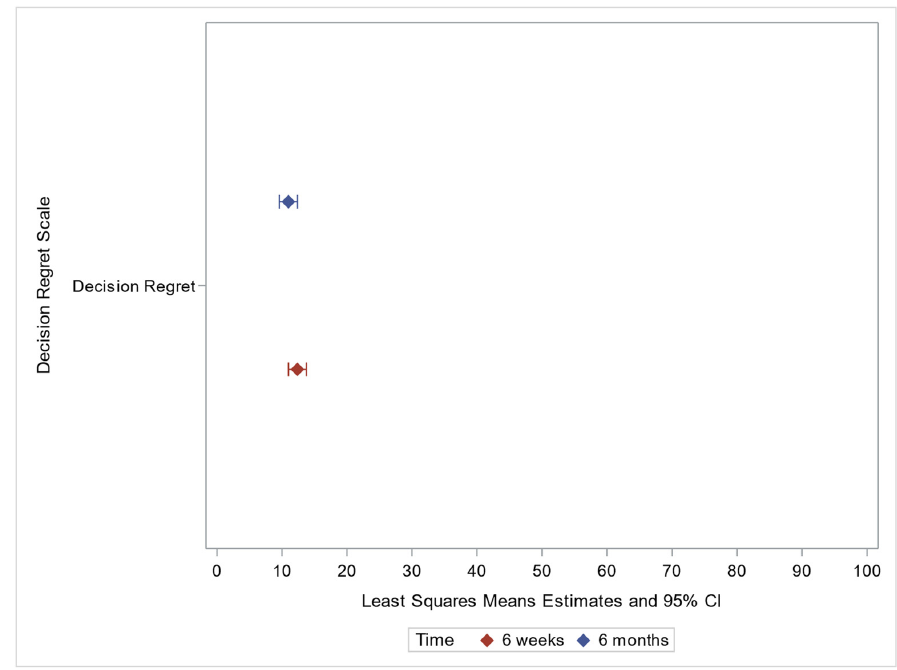
Figure 3. Decision Regret Factor Plot